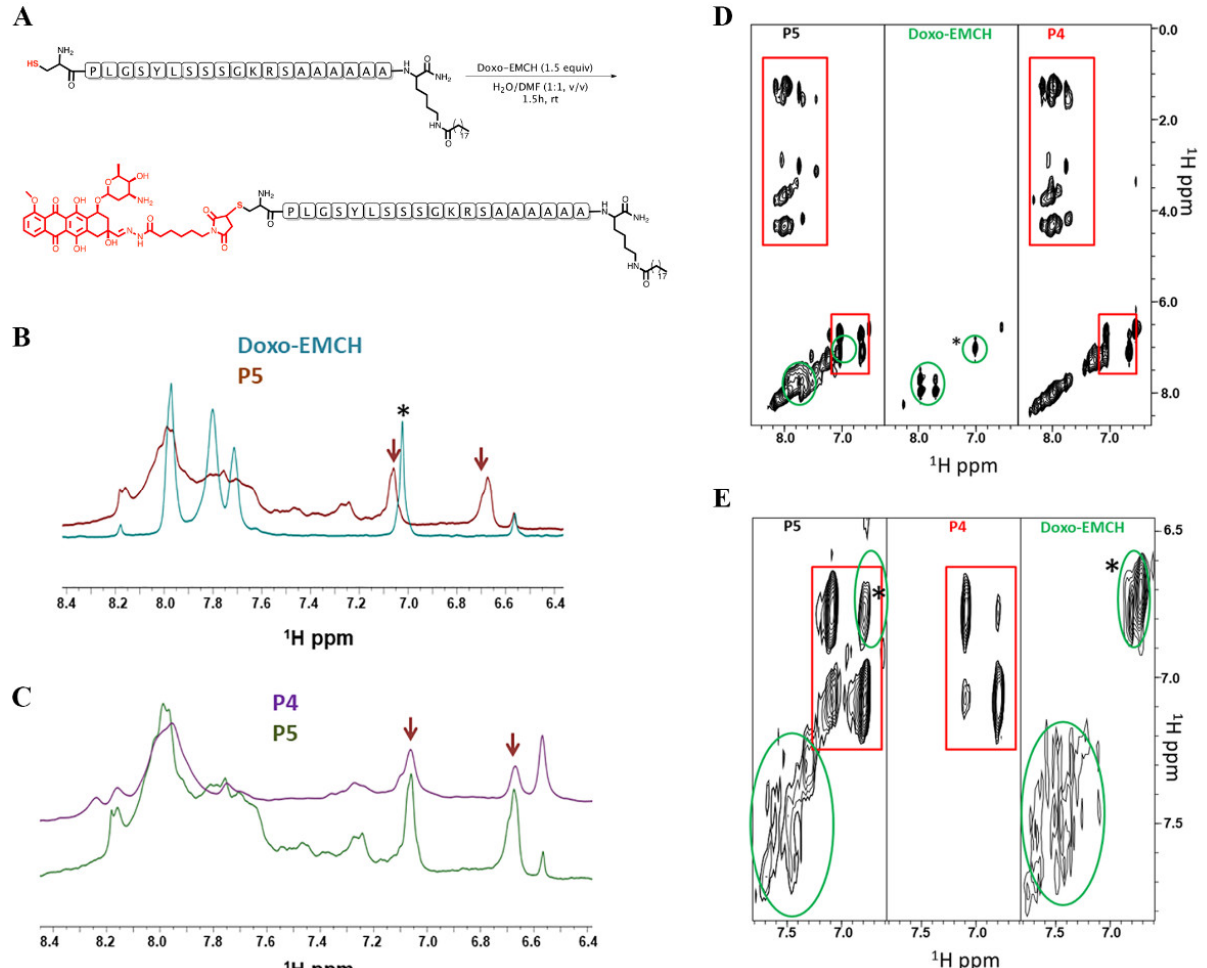
Figure 3 . Synthetic strategy for achieving the conjugation of peptide P4 to Doxo ( A ). Comparison between 1D [ 1 H] NMR spectra recorded in DMSO of Doxo-EMCH (light blue) and P5 (Red). The * and arrows are pointing to the double bond in the maleimide ring and the tyrosine aromatic protons in the P4 peptide, respectively ( B ). Comparison of 1D [ 1 H] NMR spectra acquired in DMSO of P5 (green) and P4 (violet) peptides, signals from aromatic protons of tyrosine are indicated by arrows. Chemical shifts were referenced to the DMSO signal at 2.55 ppm ( C ). Comparison of 2D [ 1 H, 1 H] TOCSY spectra of P5 (left side, D ), Doxo-EMCH (central, D ) and P4 peptide (right side, D ). The spectral region containing correlations including HN and aromatic protons are shown. The red rectangles highlight signals from the P4 peptide whereas, green cycles indicate peaks from Doxo-EMCH. The * points to a peak deriving from protons of the maleimide double bond ( D ). 2D [ 1 H, 1 H] TOCSY spectra recorded in D 2 O of P5 (left side, E ), P4 (central, E ), and Doxo-EMCH (right side, E ). Red rectangles indicate peaks from aromatic protons in the tyrosine of the P4 peptide. Green cycles encompass peaks from Doxo-Maleimide. Chemical shifts were referenced with respect to residual water peak at 4.75 ppm ( E ).